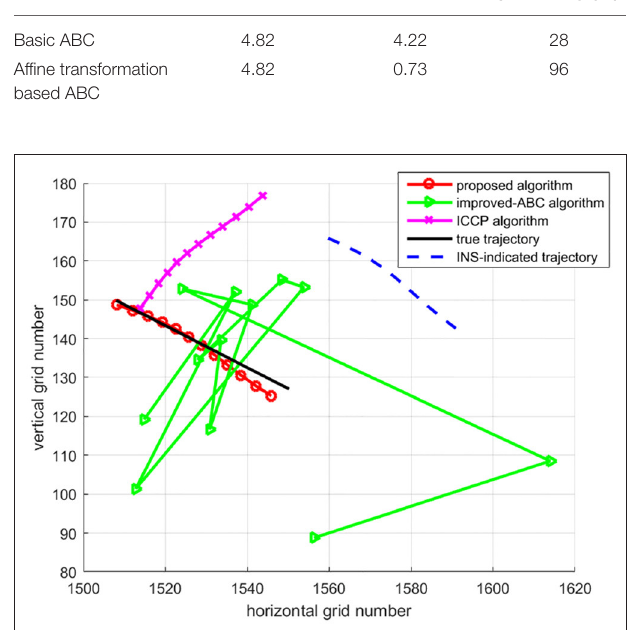
FIGURE 4 | Position errors of basic ABC.